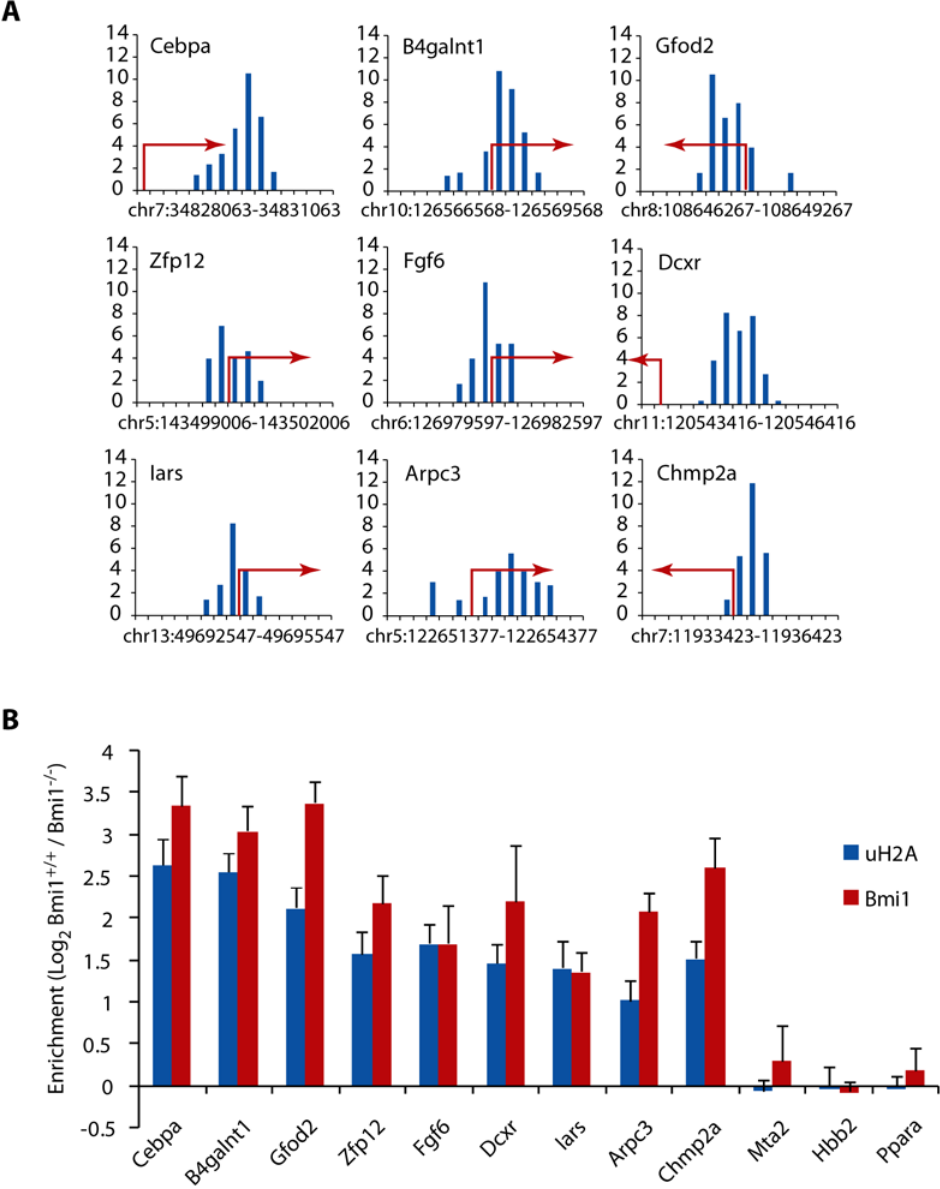
Figure 2. Bmi1-dependent promoter uH2A enrichment at a sub-set of gene promoters. (A) Bmi1-dependent tag density at selected gene promoters that contain peaks defined by the TIROE algorithm. Red arrow indicates the start and direction of transcription. (B) ChIP-qPCR validation of uH2A peaks (blue bars) and Bmi1 enrichment (red bars) was carried out in WT and Bmi1 null MEF cells. Enrichment was normalized to input control and data is presented as log 2 value of WT versus Bmi1